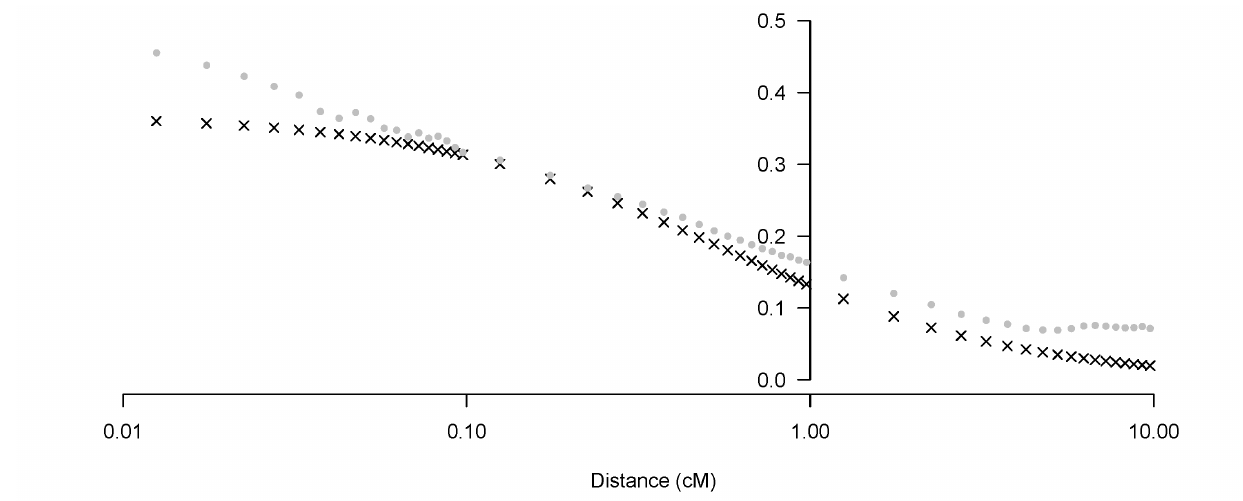
Figure 4. Predicted r 2 vs observed r 2 vs the mean distance between markers (cM, log scale), using the r 2 in equation